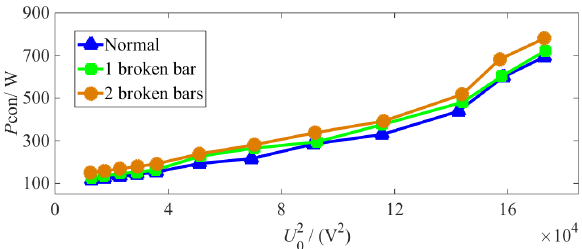
Figure 19. Characteristic curve under no-load conditions.